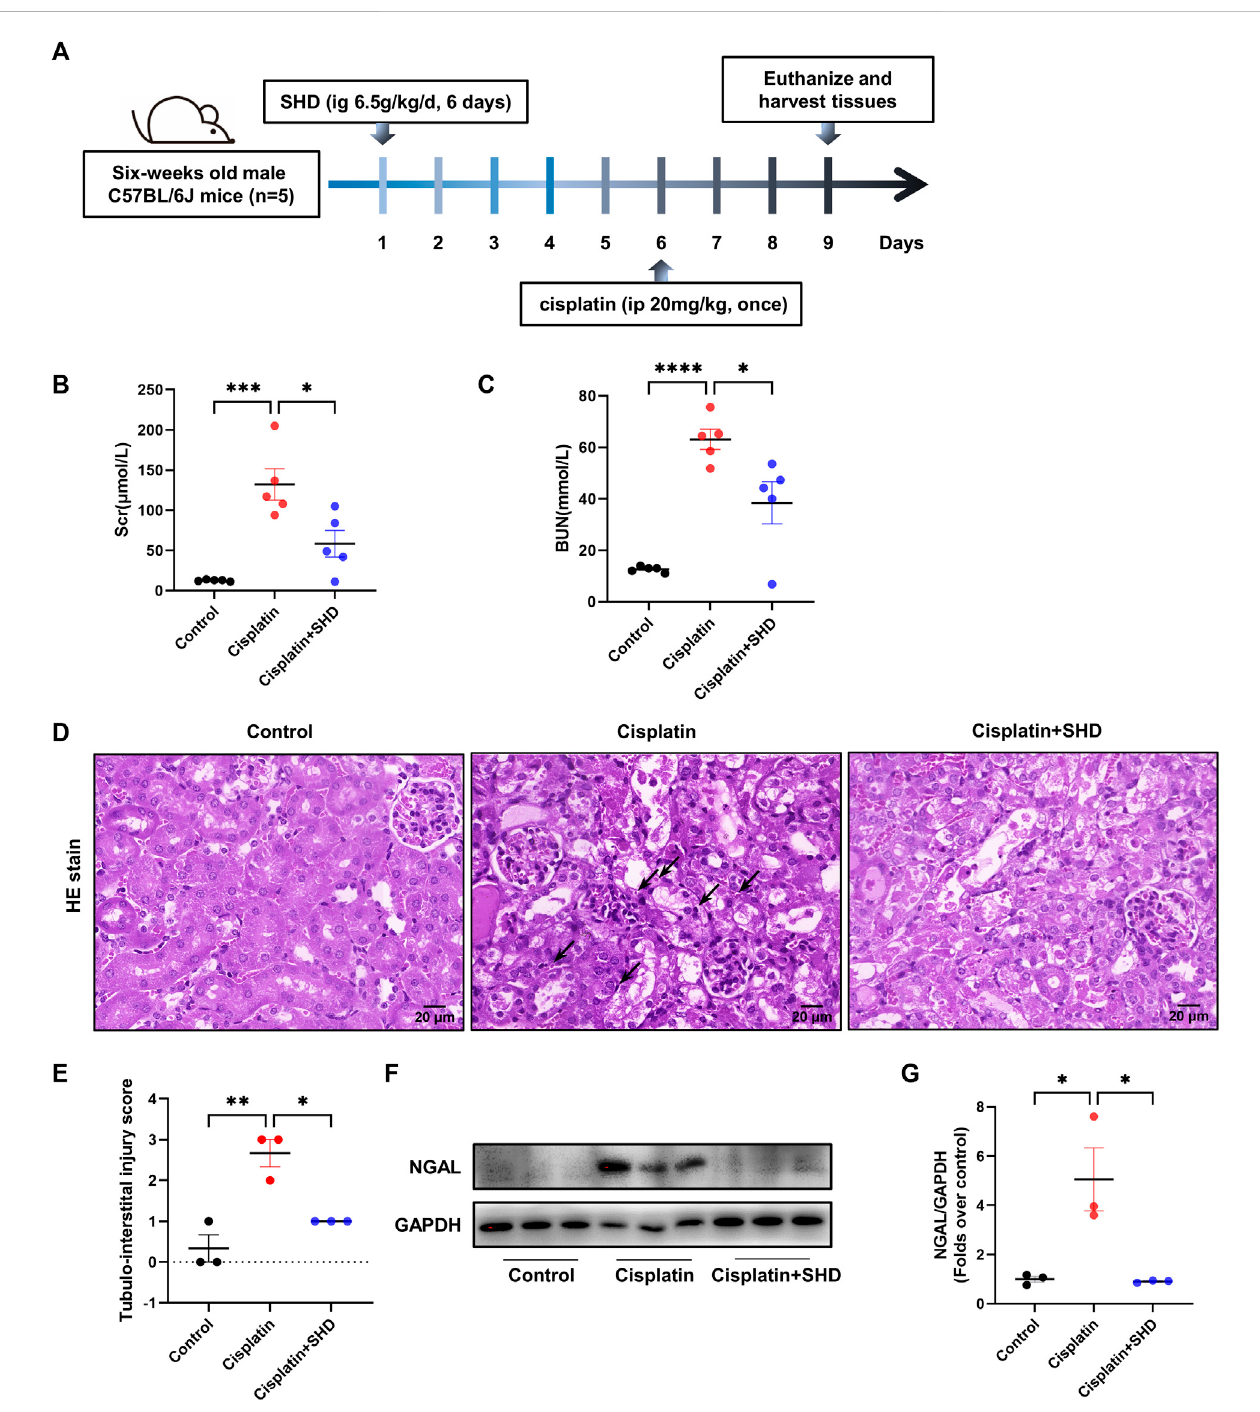
FIGURE 5 EffectsofSHDonrenaldysfunctionandtubulardamageinducedbycisplatin. (A) Diagramoftheexperimentalprotocol. (B)